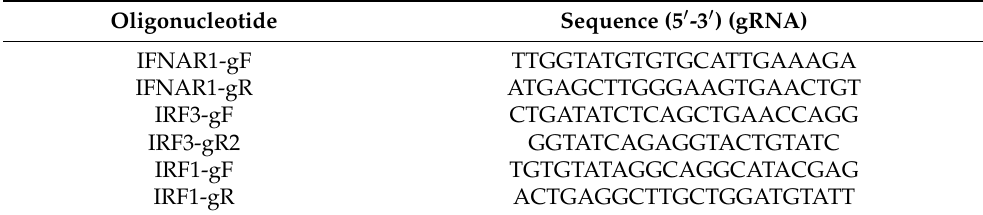
Table 3. Oligonucleotides for the amplification of edited genomic